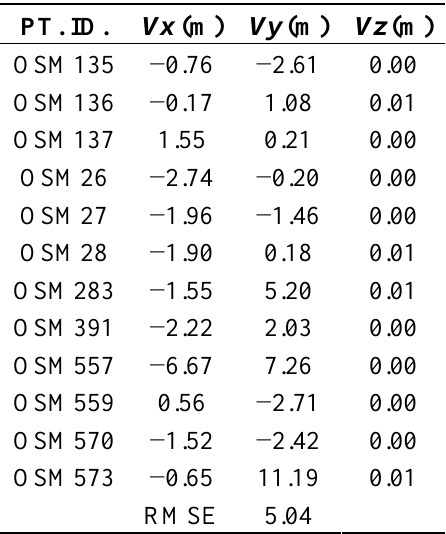
Table 2. Adjustment